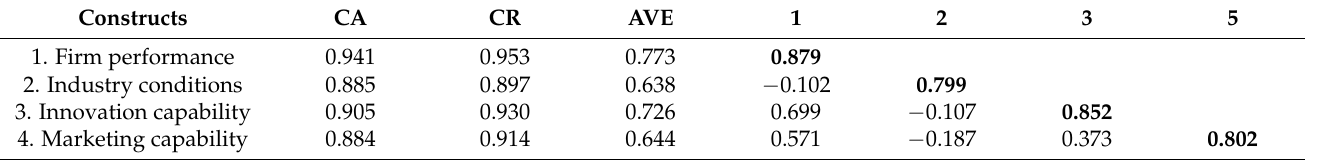
Table 1. Measurement model